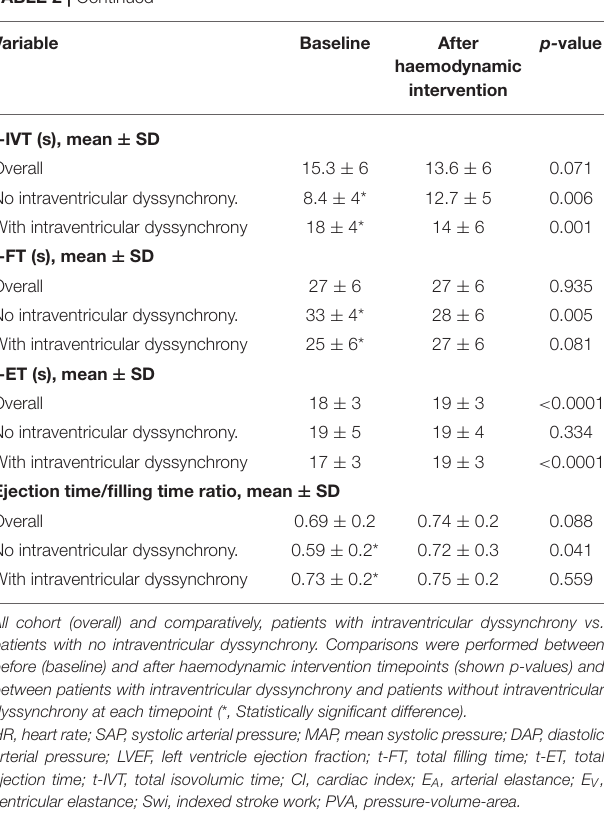
The baseline ratio of ejection time to filling time was high in patients with intraventricular dyssynchrony (0.73 ± 0.2 vs. 0.59 ± 0.2, p = 0.031).